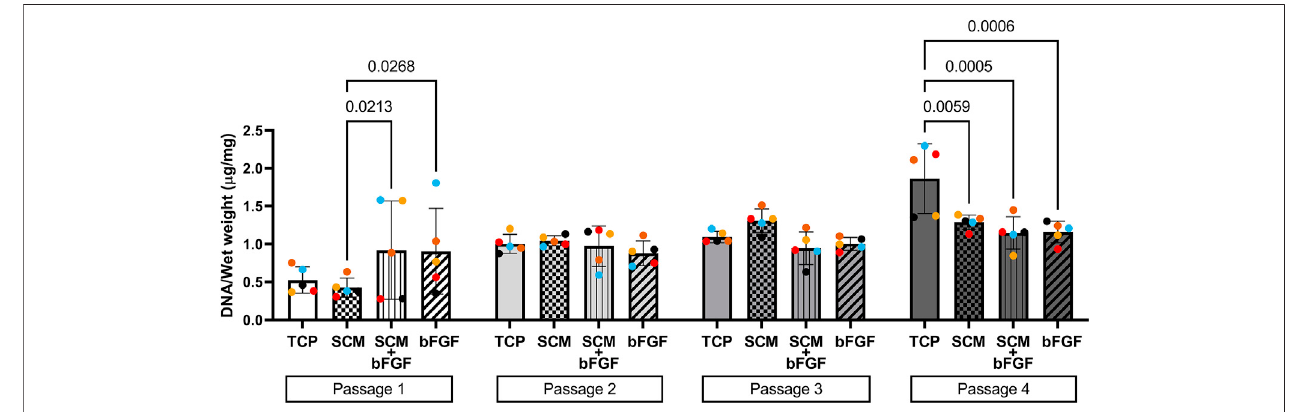
FIGURE 6 | DNA content of aggregates. DNA was extracted from cartilage aggregates and normalized to wet weight ( fi ve donors, ≥ 2 aggregates per donor, each color represents a donor) at each of four passages on tissue culture plastic (TCP), synoviocyte-derived extracellular matrix (SCM), on synoviocyte matrix with bFGF